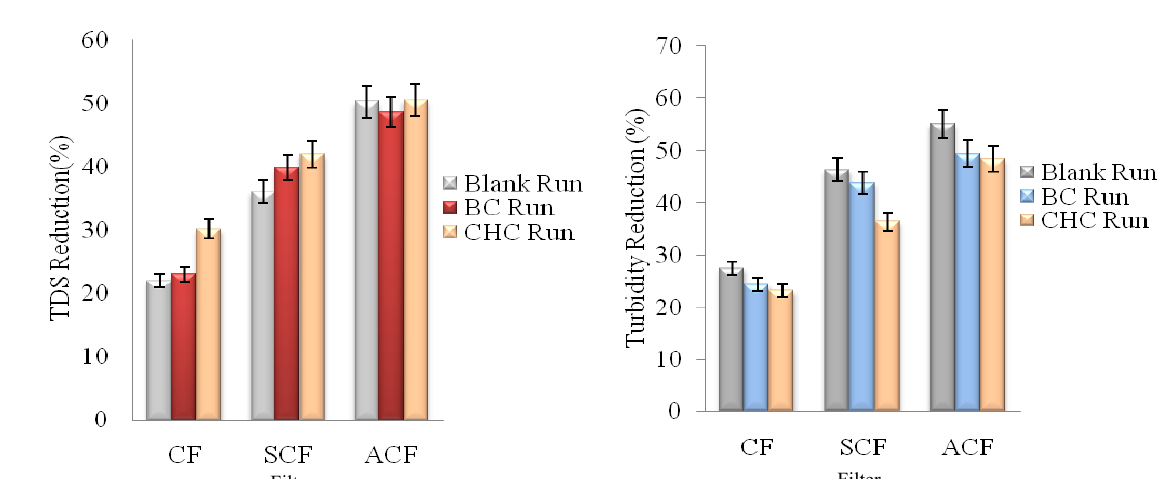
Fig. 3a: TPH removal Fig. 3b: Microbial load reduction (MR)